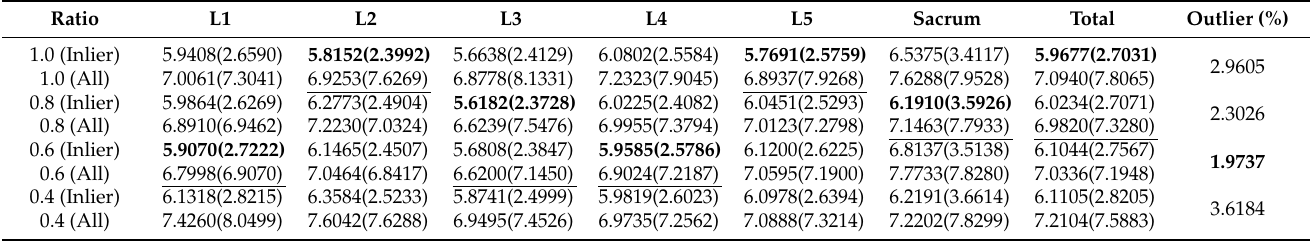
Table 3. Comparison of center distance error of Pose-Net according to the size of the random spine cutout (RSC) region. The value having the lowest distance error for each column in (Inlier) is marked in bold and underlined for